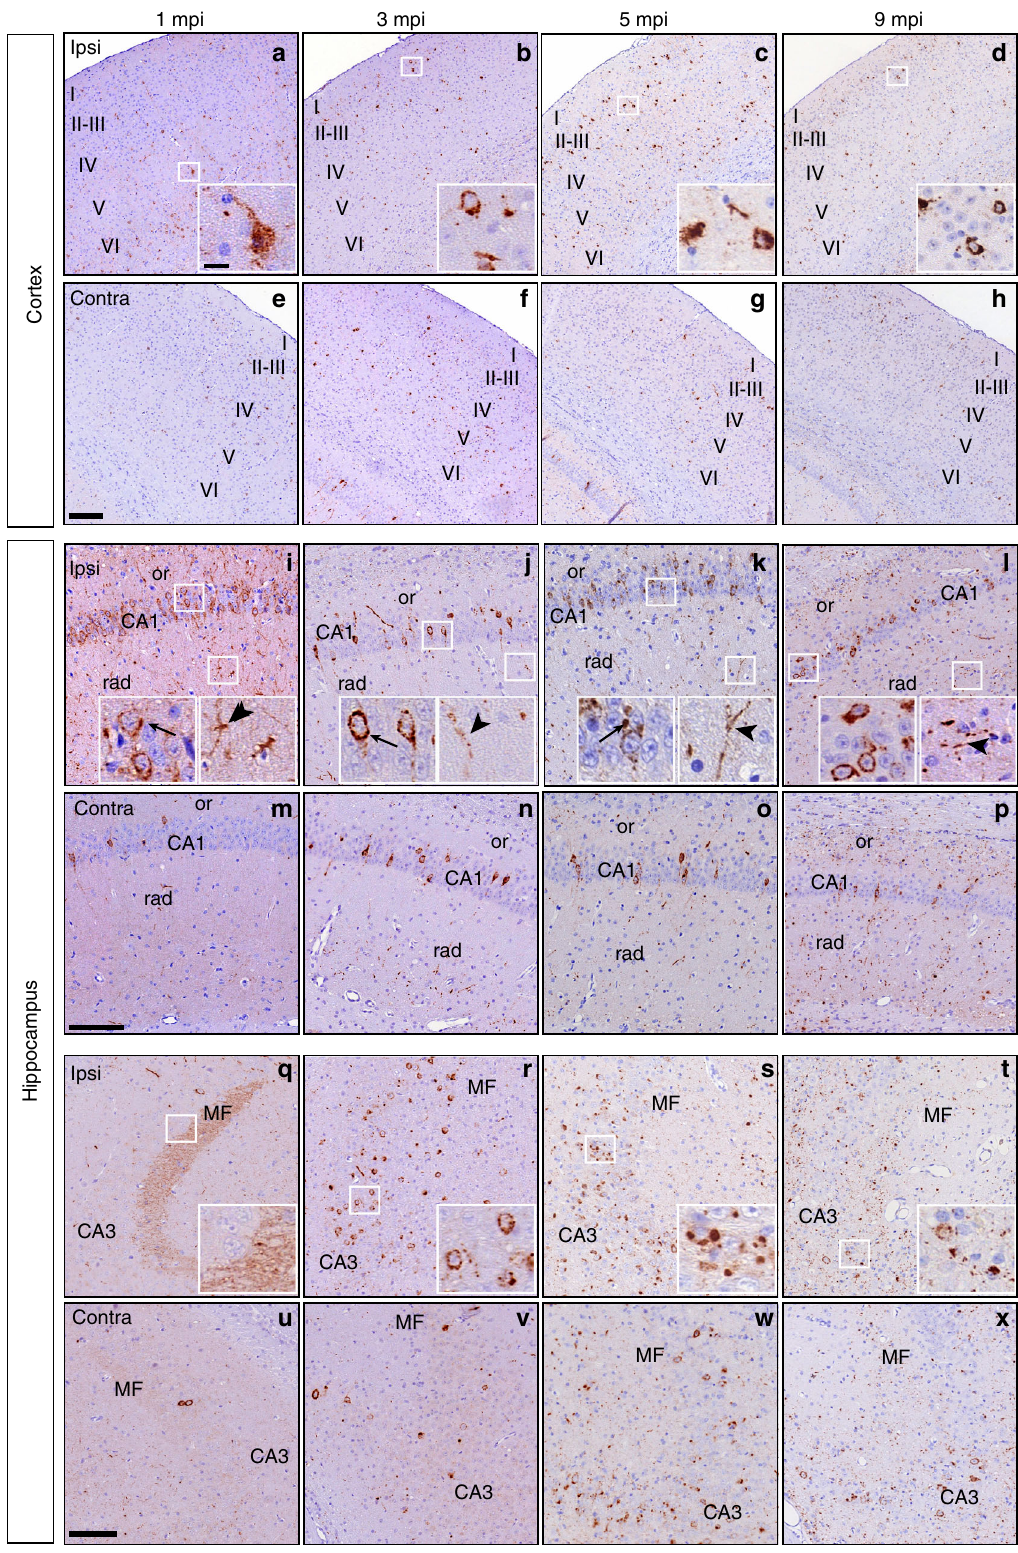
(Supplementary Fig. 11). In gray matter, double IF analysis con fi rmed that neurons accumulate the most abundant pTDP-43- positive inclusions (Supplementary Fig. 11a – c) with no appreci- able co-localization of pTDP-43 with GFAP (Supplementary Fig. 11d – f) and Iba1 (Supplementary Fig. 11g – i). Only at later